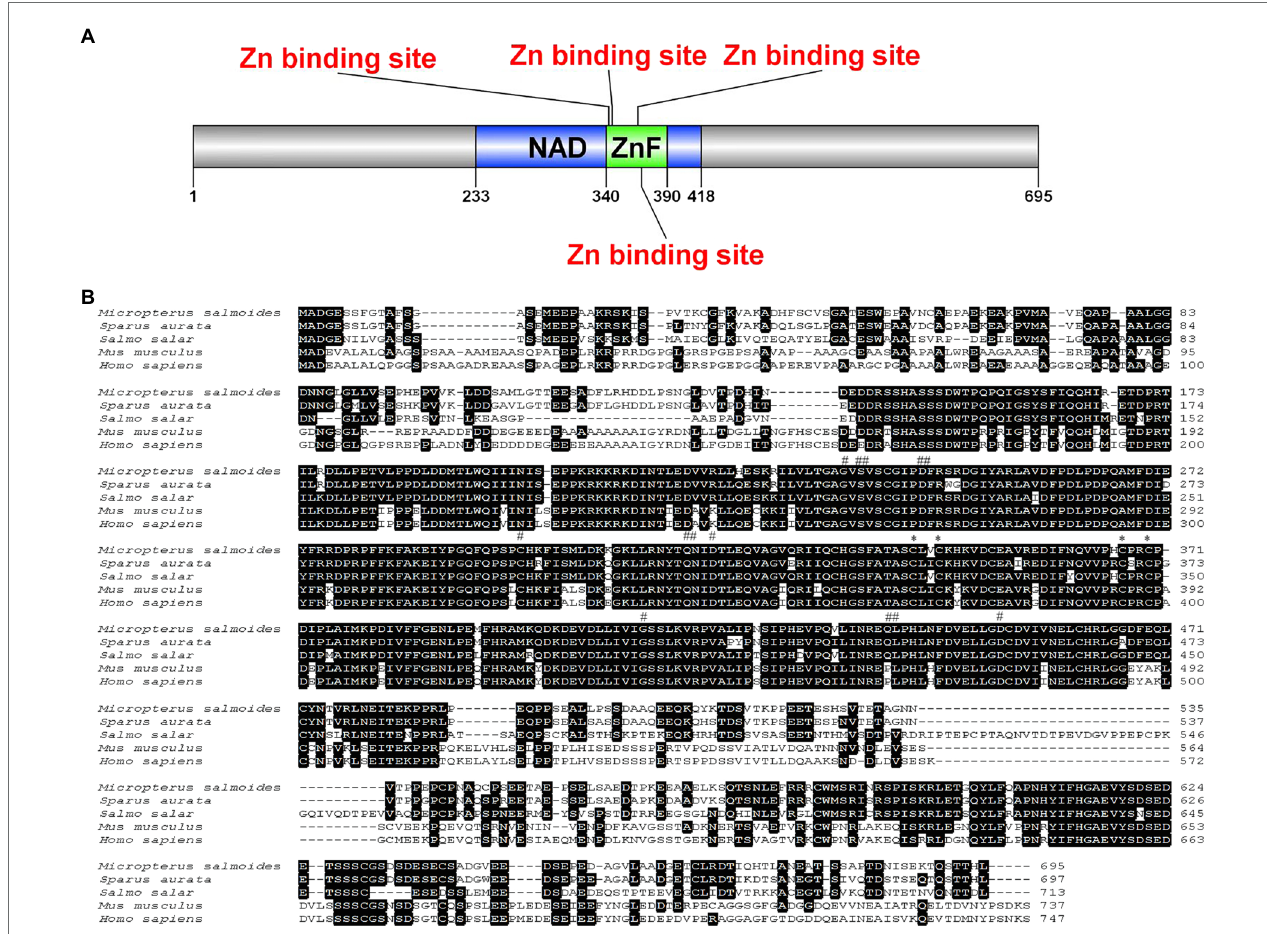
FIGURE 1 | Schematic diagram prediction of largemouth bass SIRT1, including NAD + binding domain, zinc ion binding module and unstructured region (A) . Multiple sequence alignment of SIRT1 with deduced amino acid sequences of other fish or mammal animals (B) , including Sparus aurata (AHX56273.1), Salmo salar (ENSSSAT00000005225.1), Mus musculus (NP_062786.1) and Homo sapiens (NP_036370.2). The predicted protein domain is indicated by horizontal line, and the substrate binding site, NAD + binding site and Zn binding site are indicated by the “ * ”, “#” and “##” at the top of the sequence,